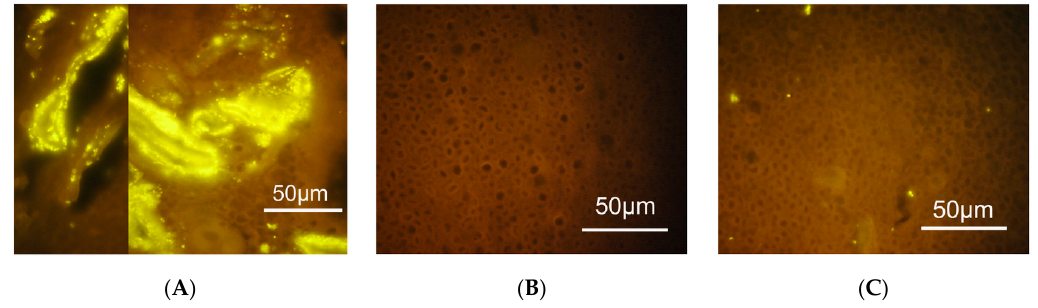
Figure 2. Fluorescence in situ hybridization (FISH) analysis of endometrial samples with probes targeting bacterial vaginosis-associated and other bacteria. ( A ) Gardnerella dominated polymicrobial biofilm attached to the endometrium. ( B ) Endometrial sample free of bacteria. ( C ) Bacteria other than Gardnerella colonizing the endometrial epithelium. Swidsinski et al. [130].